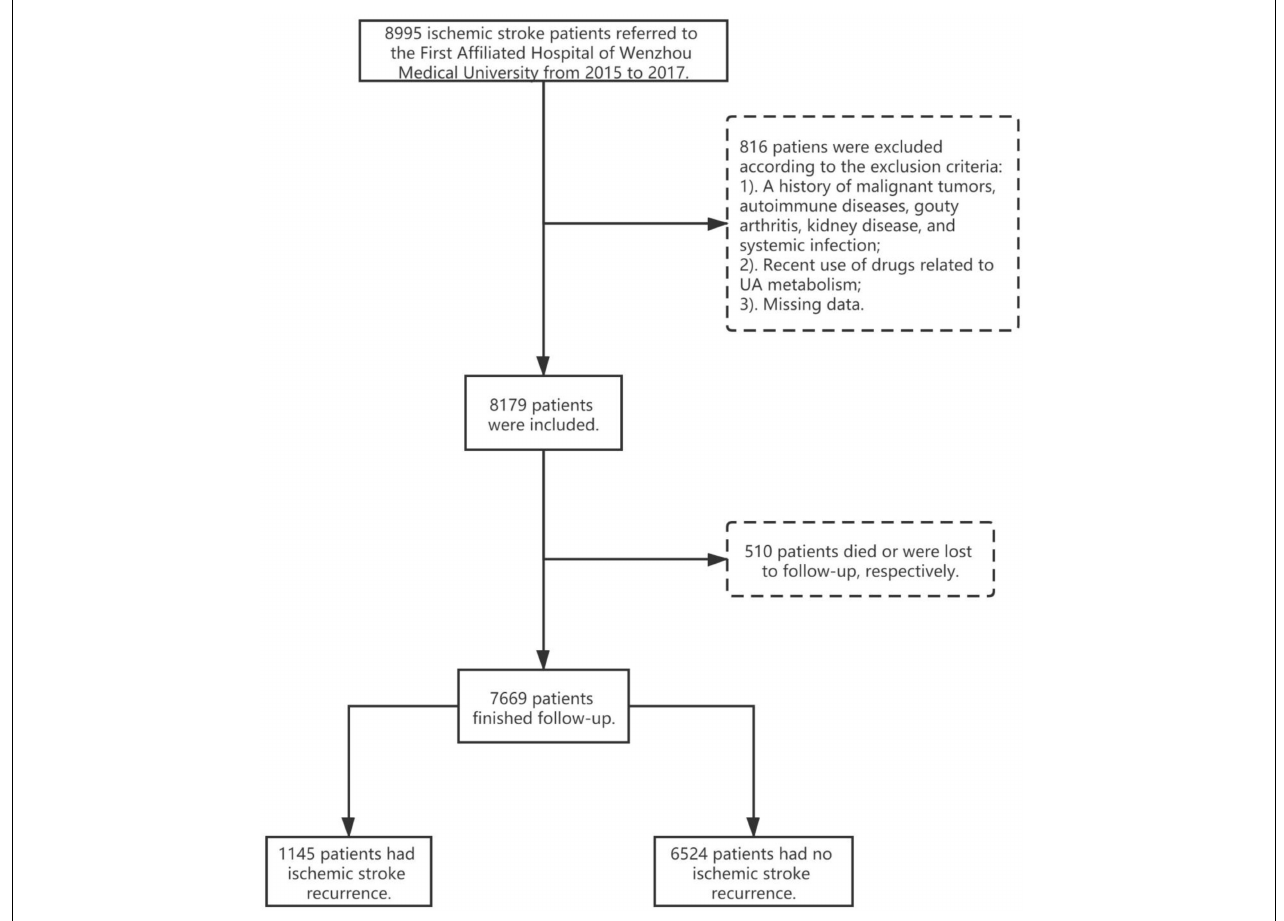
FIGURE 1 | Flow chart of this